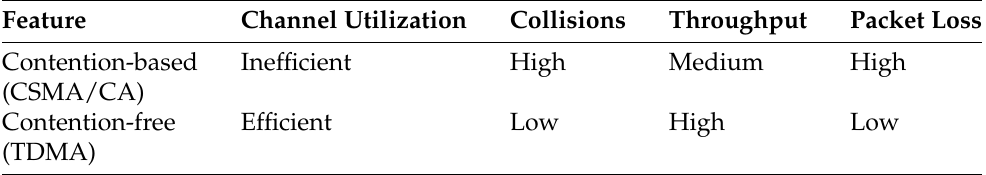
Table 2. Comparison between contention-based and contention-free MAC protocols